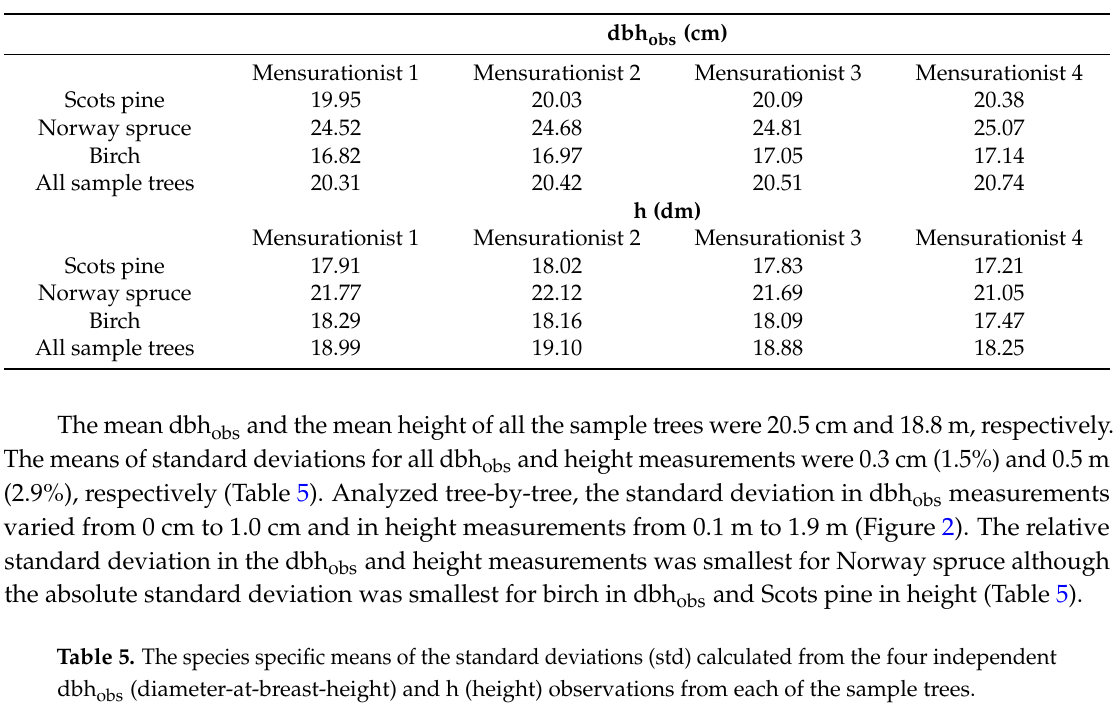
Table 4. Mean values of dbh obs (diameter-at-breast-height, cross measurement) and height (h) measurements by different mensurationists.